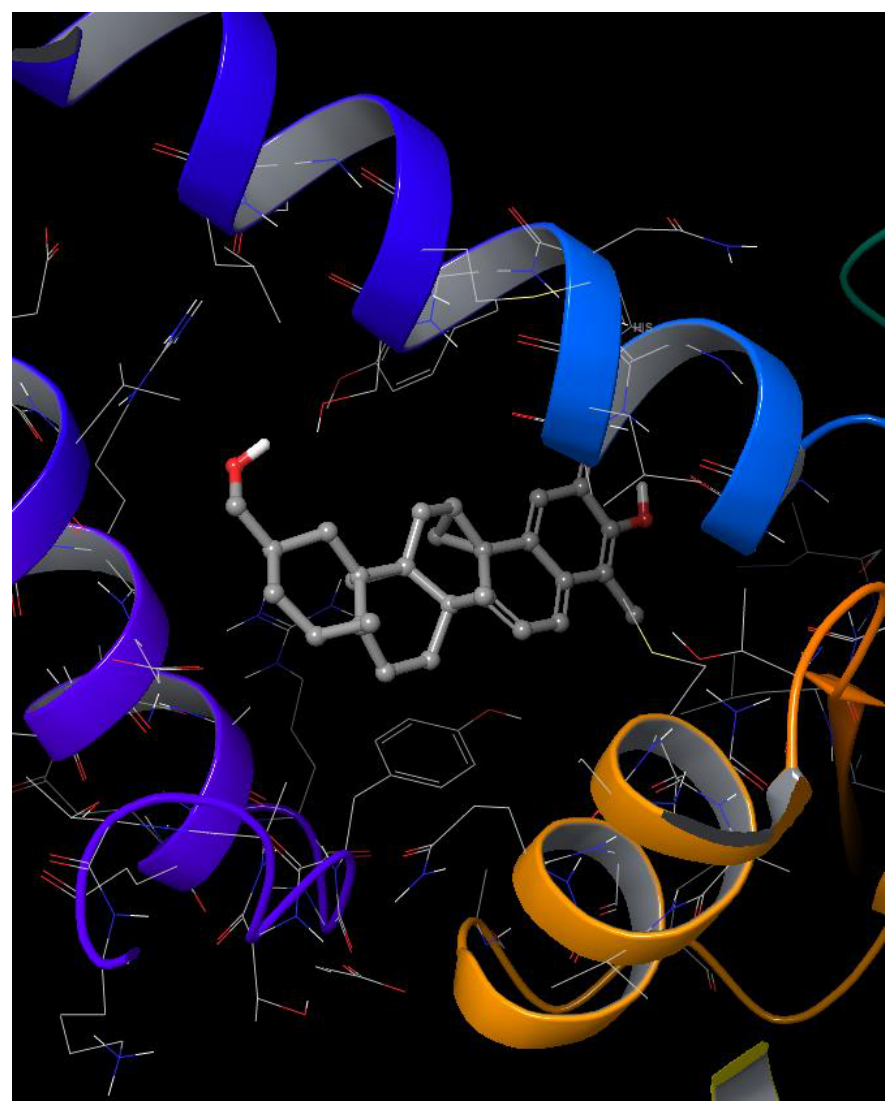
Figure 10. Induced-fit docking studies of ZINC95485880 ligand complex. The Figure illustrates the induced fit pose of ZINC95485880 (shades of gray) docked in the active site of